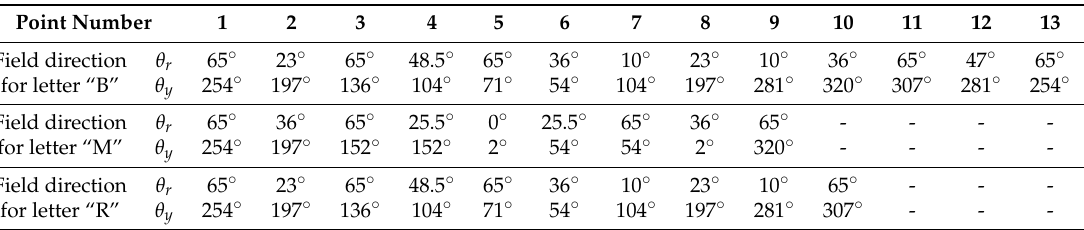
Figure 7. ( a – c ) compression between the desired path (using the initial letters of the biomedical micro robot (BMR)) and the experimental results, ( d – f ), the experimental results (the red dots are the end-effector position in each step). Table 2. The magnetic field direction for 2D steering of the microrobot in an arbitrary path.